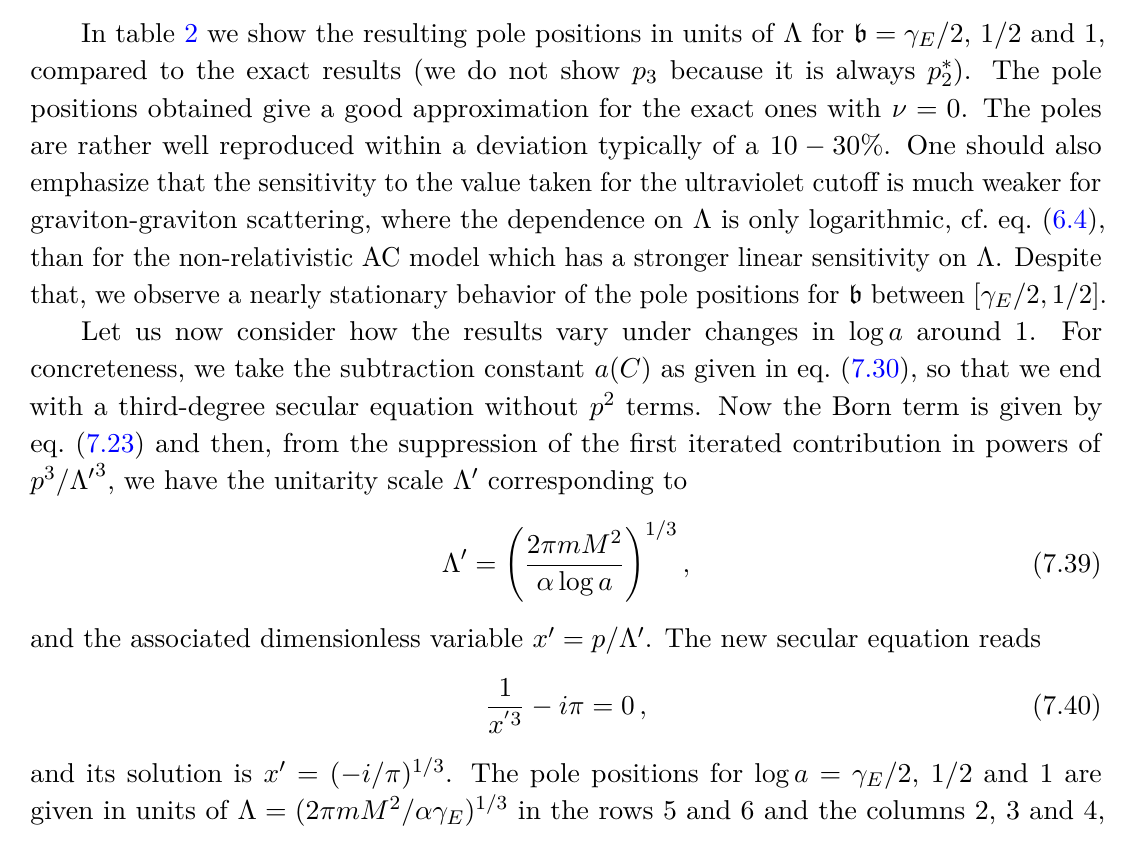
Table 2 . Lightest pole positions in units of Λ = (2 πmM 2 /αγ E ) 1 / 3 of the S -wave PWA T AC for the AC model. The second, third and fourth columns give the values obtained for the unitarized Born-term PWA V AC ( p 2 ) , and the exact results are shown in the last column. In the rows 2 and 3 0 a three-momentum cutoff b Λ , with b = γ E / 2 , 1/2 and 1, is used in the secular equation (7.38). For the rows 4 and 5 there is no linear term in the new secular equation (7.40) and log a = γ E / 2 , 1/2 and 1. For this case the pole positions vary as (2 log a ) − 1 / 3 with respect to the exact values. There is a third pole at p 3 = − p ∗ which is not 2